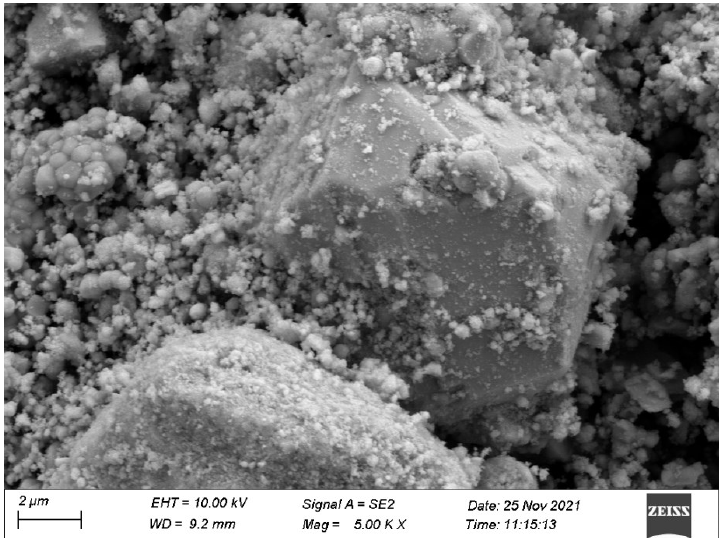
Figure 11. ( a ) XPS spectra of O 2 − derived from the IBHP; ( b ) XPS spectra of In 3+ derived from the IBHP; ( c ) XPS spectra of Y 3+ derived from the IBHP; ( d ) XPS spectra of Bi 3+ derived from the IBHP; ( e ) XPS spectra of Sn 4+ derived from the IBHP; ( f ) XPS spectra of Sb 5+ derived from the IBHP.